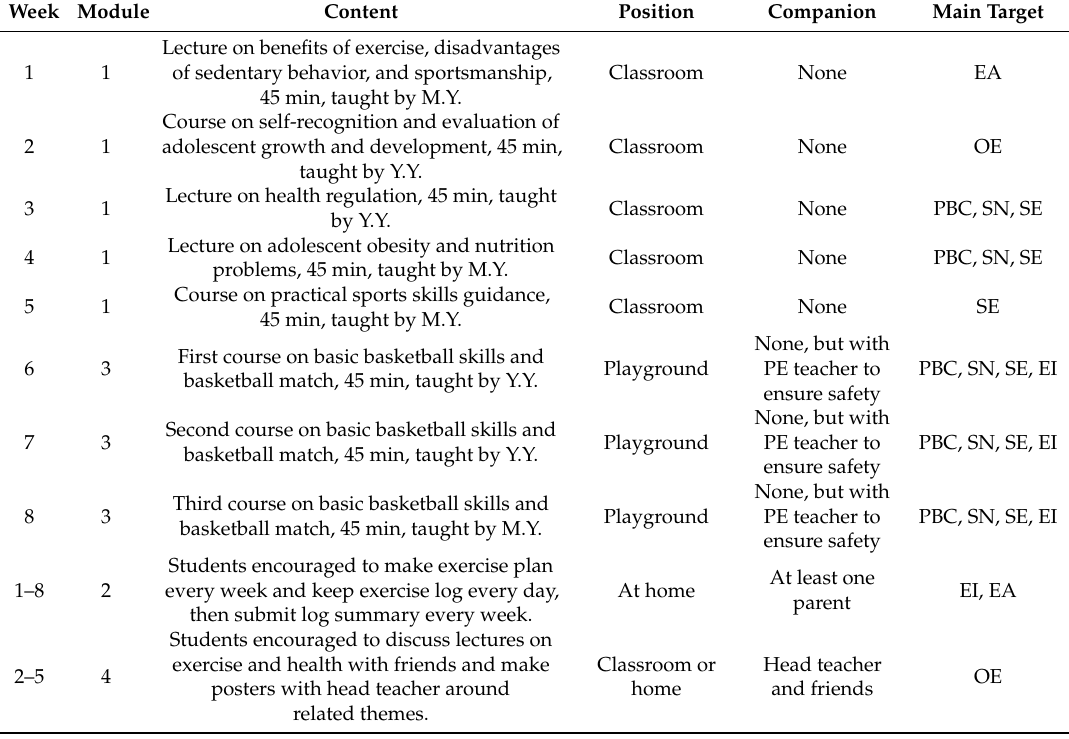
Table 1. Details of school-based physical activity intervention for seventh-grade